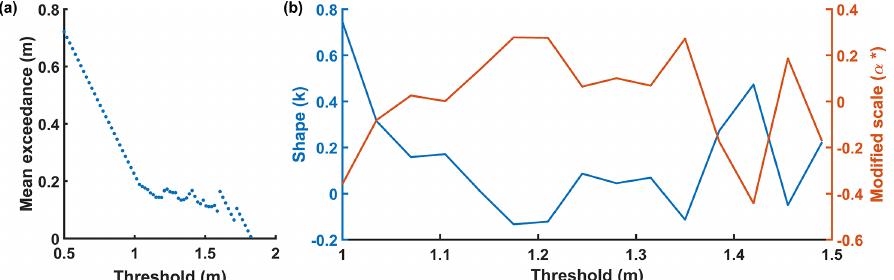
Figure 3. Typical (a) SME and (b) PS plots used for selecting a range of thresholds required for POT analysis. In this particular case, a range of 1.19 to 1.32m was selected.